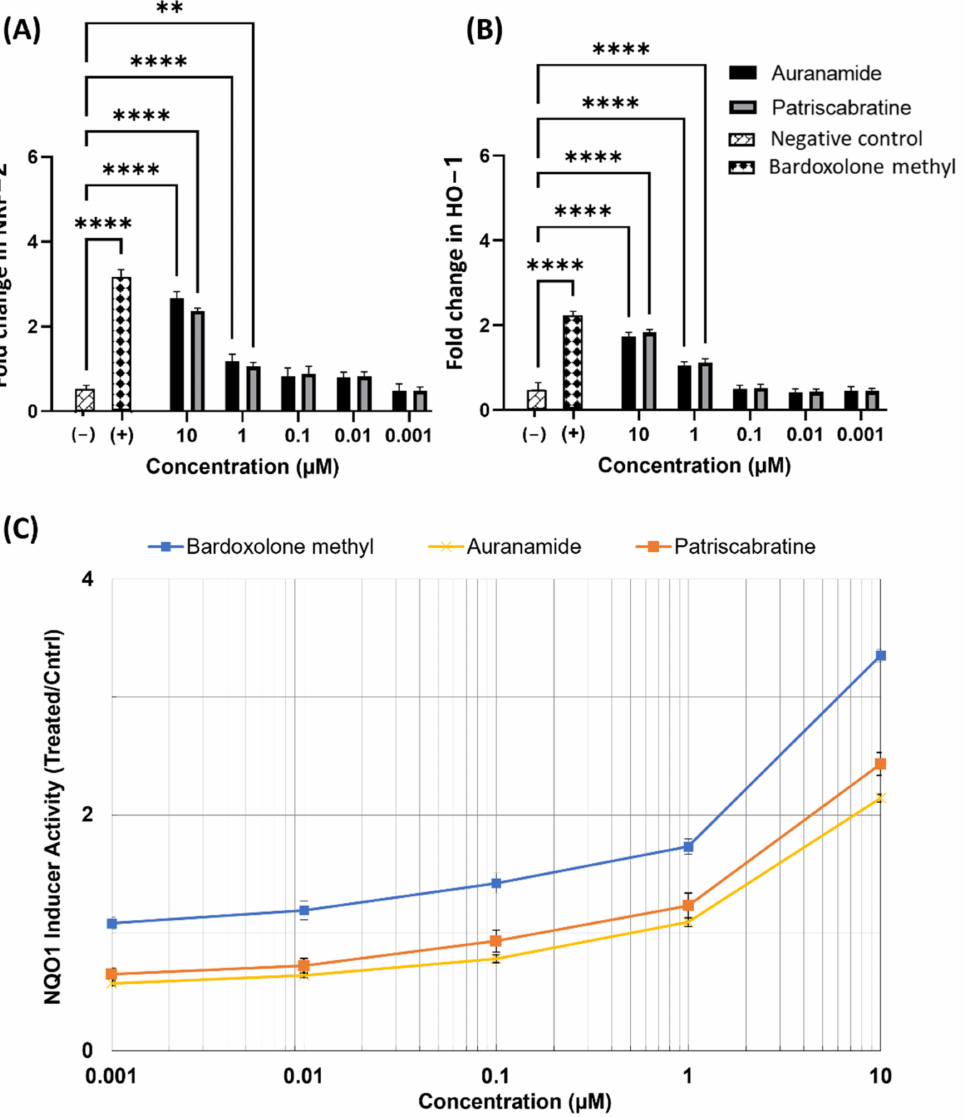
Figure 3. The effect of auranamide and patriscabratine on ( A ) NRF2 protein expression; ( B ) HO-1 protein expression; ( C ) NQO1 activity in nuclear extracts of Hepa-1c1c7 cells. The results are expressed as mean ± SD (n = 3). **, p ≤ 0.01; ****, p ≤ 0.0001 compared to LPS Ec + 0.1% DMSO